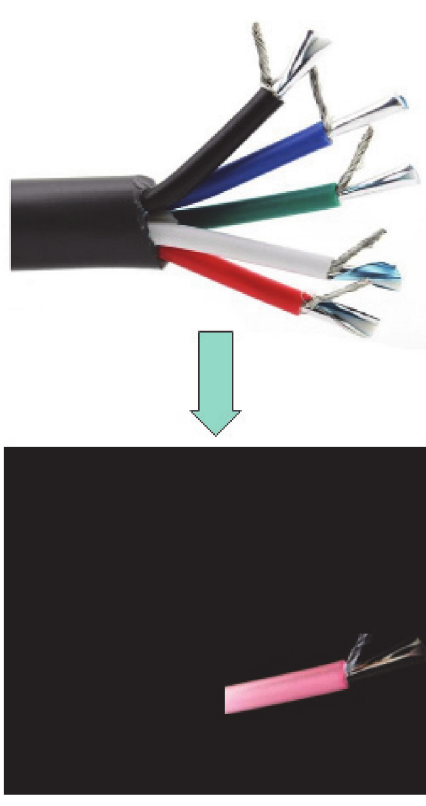
Figure 8: Morphological operation.